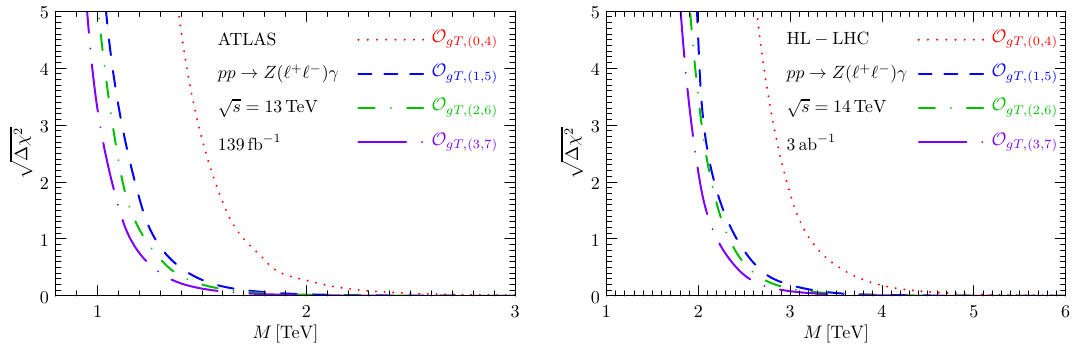
p Figure 5 . The significances ∆ χ 2 for probes of the individual dimension-8 gQGC operators O , where i = 0 , 1 , 2 , 3 , from the Z ( ‘ + ‘ − ) γ channel as functions of the cut-off scales M i . gT, ( i,i +4) The left panel shows the sensitivities obtained using the current LHC data with luminosity L = 139 fb − 1 , and the right panel shows the estimated sensitivities for the future HL-LHC √ with s = 14 TeV and L = 3 ab − 1